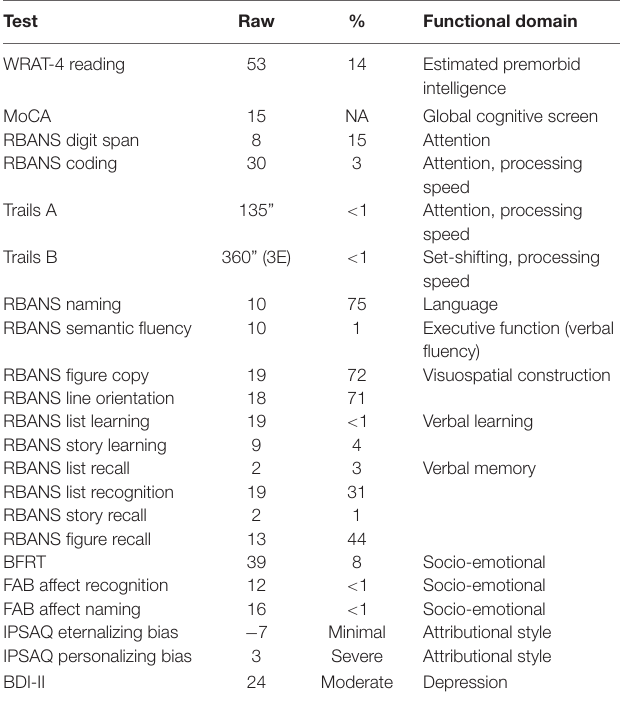
TABLE 1 | Summary of patient performance on paper-and-pencil neuropsychological tests.